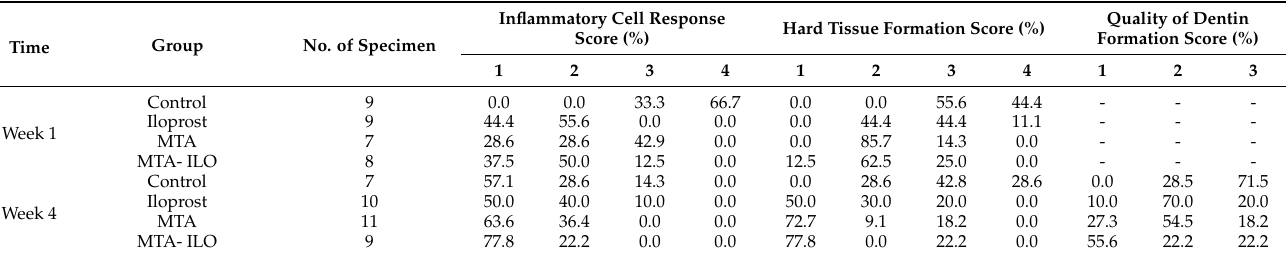
Table 2. Histological section scoring of pulps capped with different test materials.